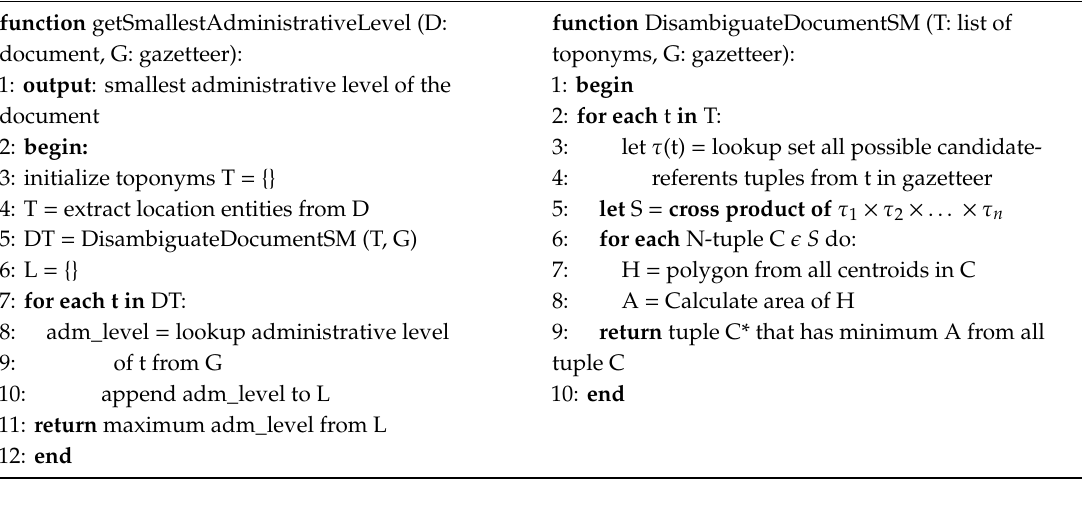
Algorithm 3. Algorithm for finding Smallest Administrative Level feature using Spatial Minimality (SM) from [12].